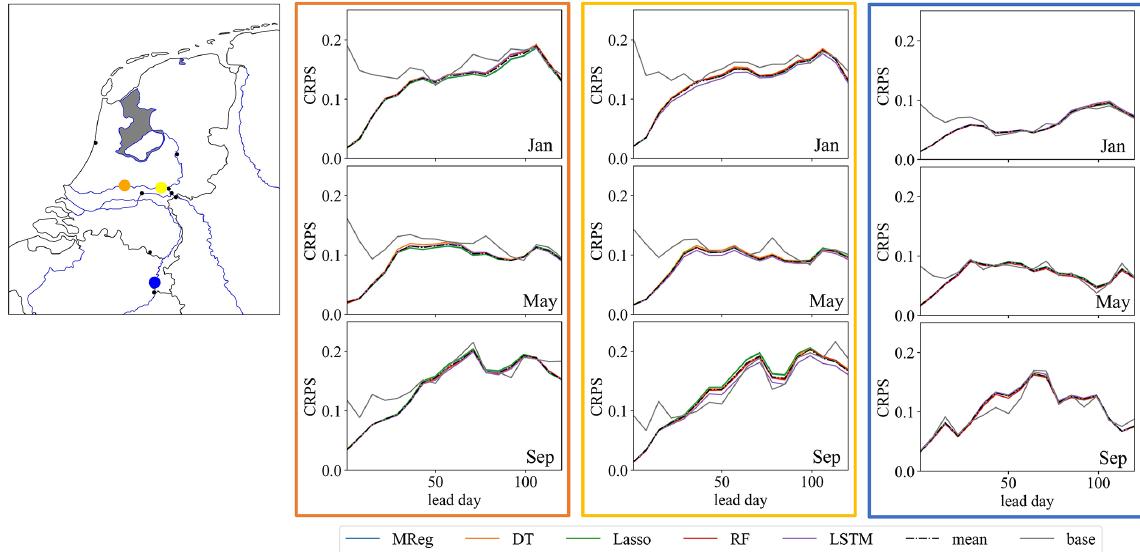
Figure 4. Overview of weekly CRPS values for January, May, and September. Different ML model scores, the average of the ML model score (dashed line), and the climatological reference (grey) are shown for three discharge stations (Hagenstein Boven in orange, Driel in yellow, and Borgharen Dorp in blue). For most months shown and for the first few lead weeks, the CRPS of the hindcast framework shows a lower score than the climatological reference. However, only minor differences between the ML models were observed. Maps were created using the Python package Cartopy (Elson et al., 2022), which uses basemap data made with Natural Earth and © OpenStreetMap contributors 2022. Distributed under the Open Data Commons Open Database License (ODbL)